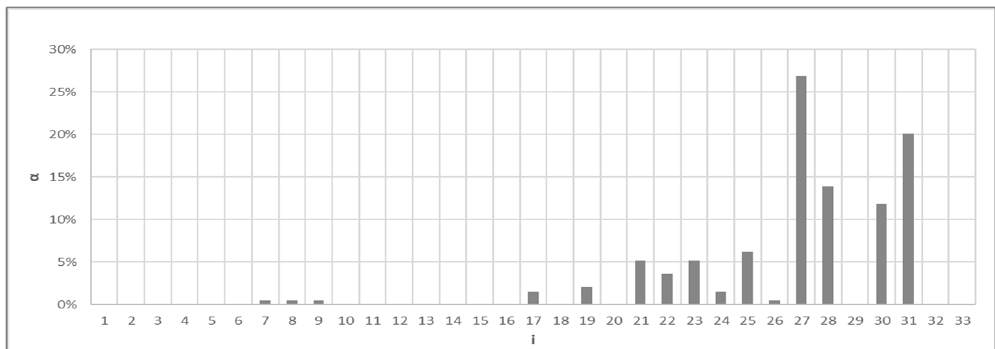
Figure 4. L171: Percentage that each stop appeared to be a Point of Maximum Occupancy.